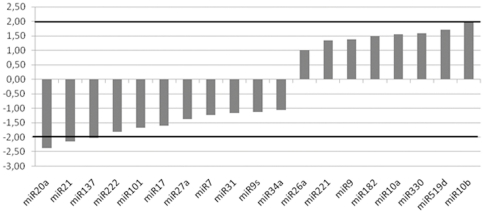
Median fold-change calculated per each miRNA between 30 paired Fresh/Frozen and FFPE samples.The y-axis represents the fold-change value.